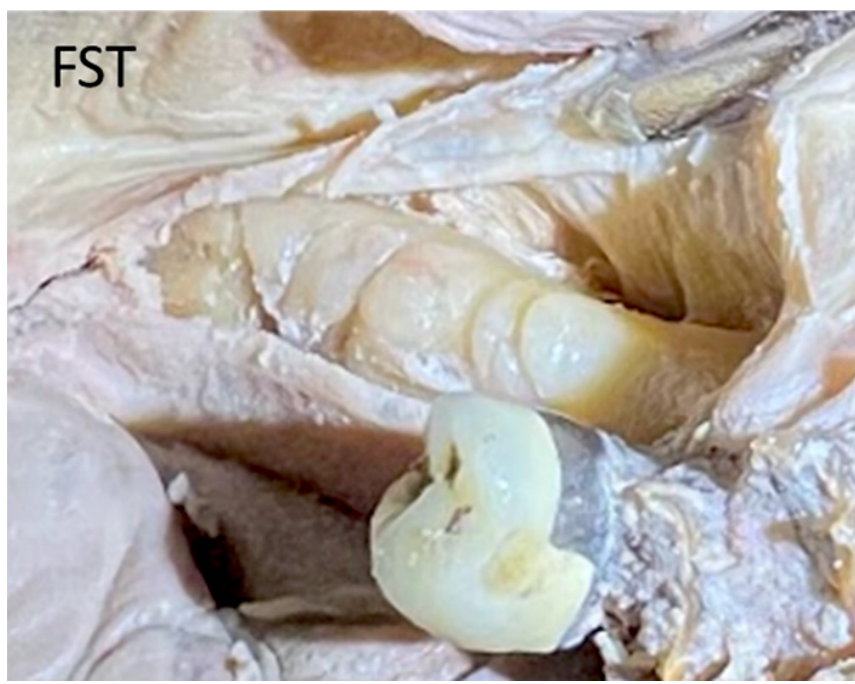
Figure 8. The design of the lingual flap of the FST in a human cadaver model, showing the release of the superficial fibers of the mylohyoid muscle.